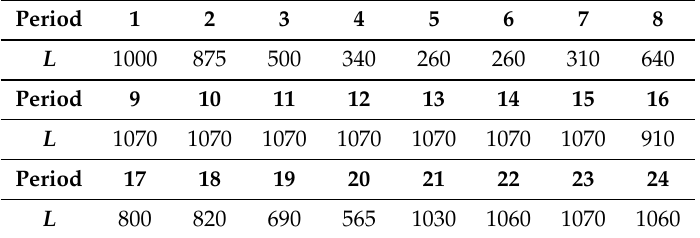
Table 1. Power demands (MW)-scenario 1. Data from [11].